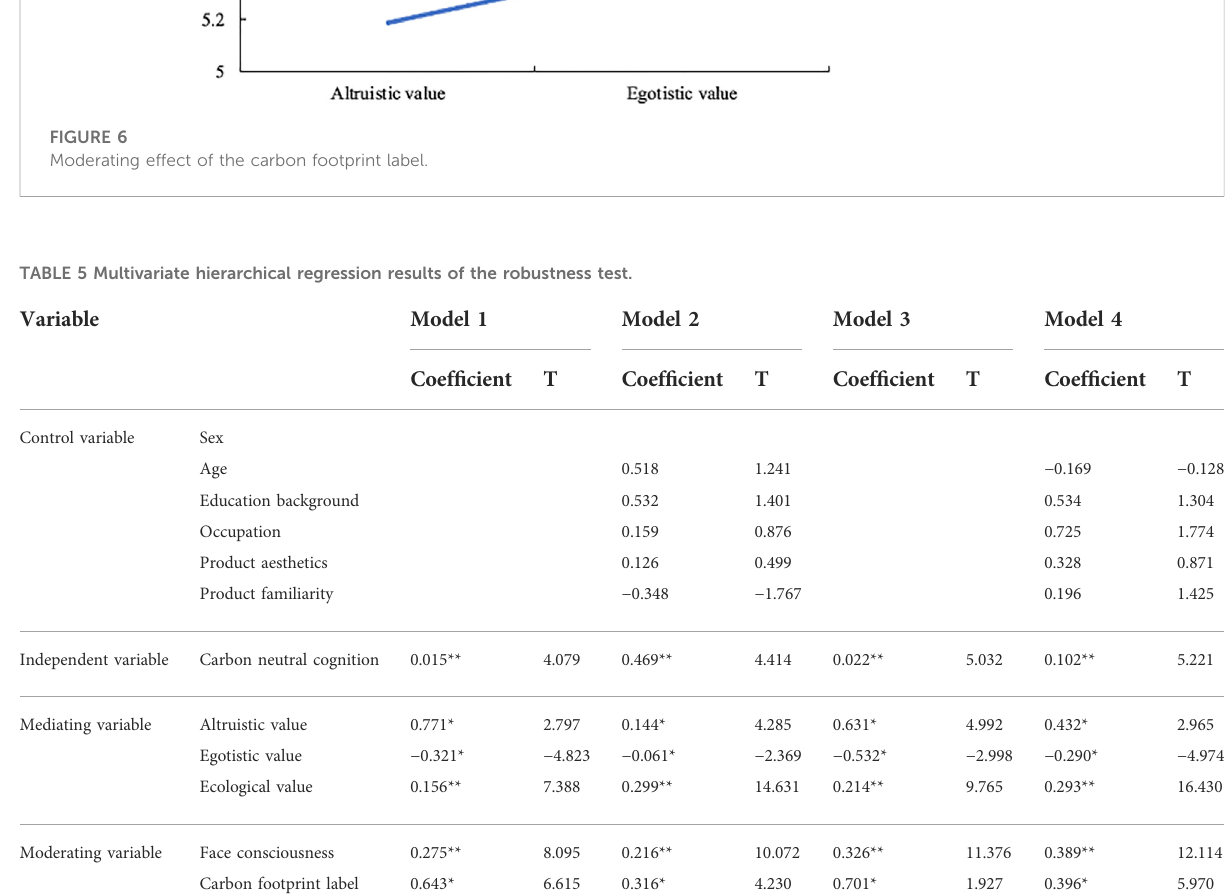
Note: N = 405, * p < 0.05, ** p <